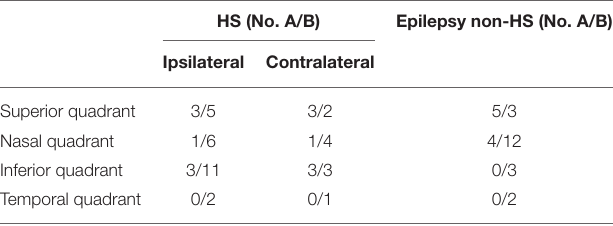
TABLE 4 | Quadrant RNFL thickness, considered as categorical variable according to the normal distribution percentiles provided by the manufacturer’s inbuilt database in individuals with HS and epilepsy